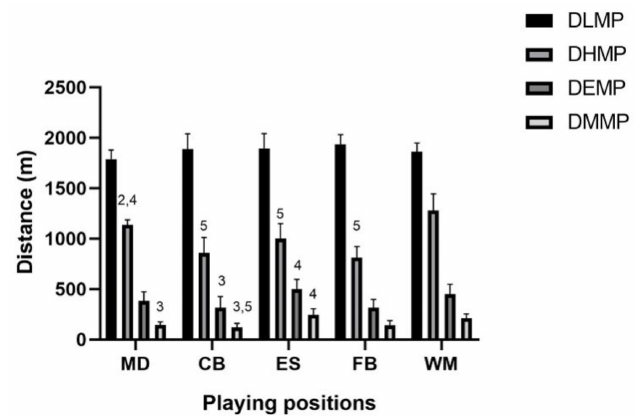
Figure 3. Playing position’s metabolic indicators (DLMP, DHMP, DEMP, DMMP) during the first half of official matches. Legend: DLMP, Distance Low Metabolic Power; DHMP, Distance High Metabolic Power; DEMP, Distance Elevated Metabolic Power; DMMP, Distance Max Metabolic Power; p < 0.05 for differences between playing positions (2 difference with central back; 3 difference with external striker; 4 difference with full back; 5 difference with wide